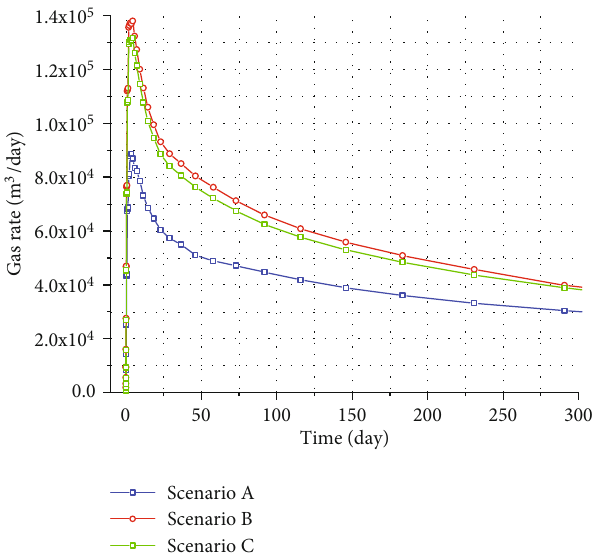
Figure 15: Gas production ratio of the three scenarios.